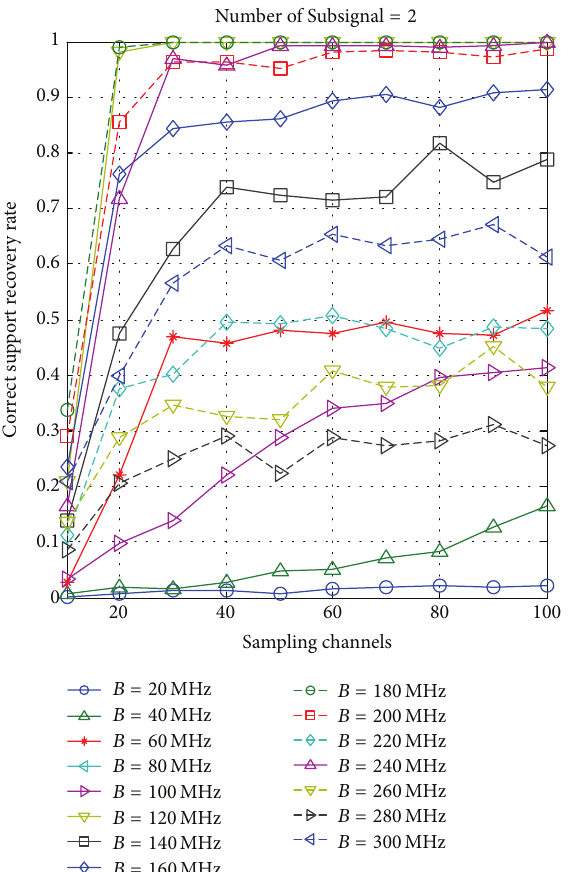
Figure 5: Recovery performance with two subsignals. Figure 6: Recovery performance with three